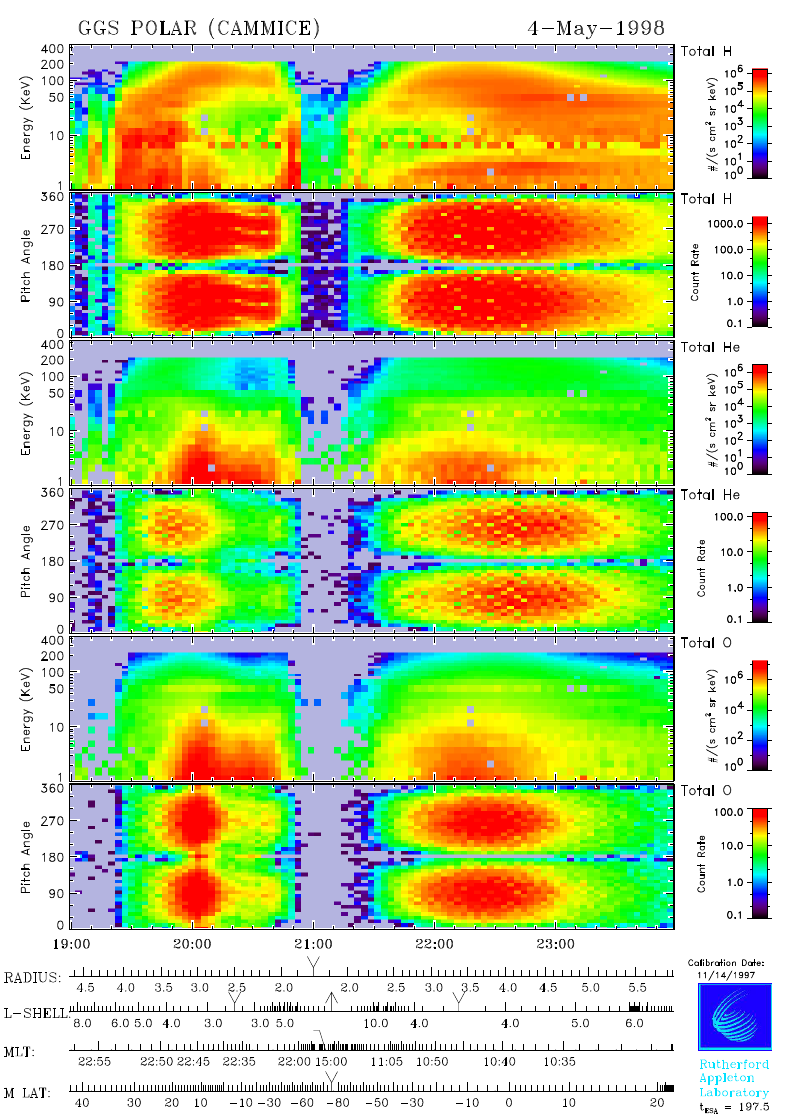
Fig. 1. Example of Polar CAMMICE/MICS measurements: Energy-time spectrograms and pitch-angle distributions for protons (upper two panels), total He (middle two panels) and total O (bottom two panels) during 4 May 1998, 19:00–24:00